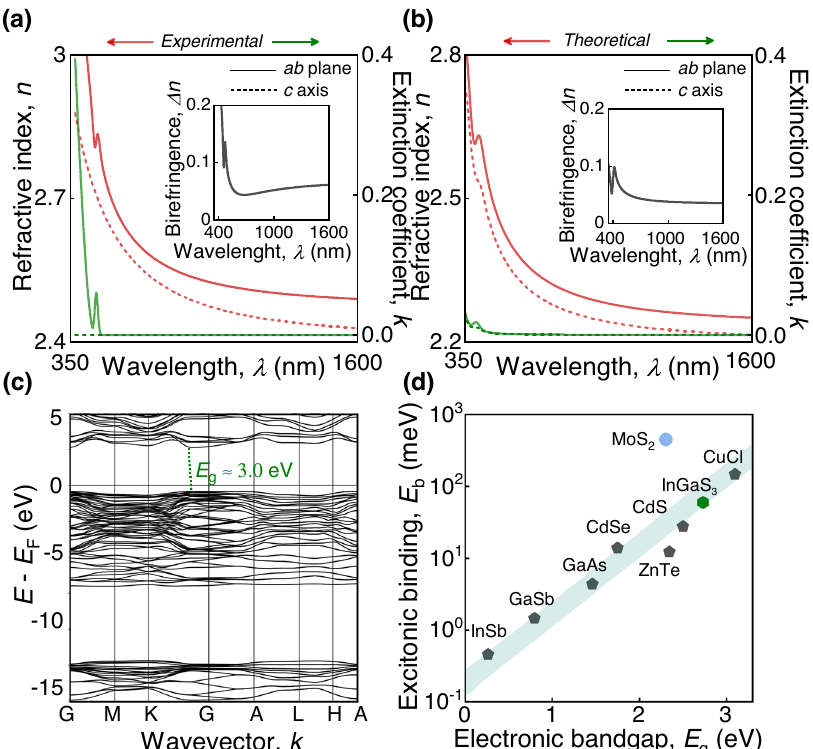
Fig. 3 Optical response of non-van der Waals InGaS 3 . a Experimental and b fi rst-principle refractive indices and extinction coef fi cients for ab -plane (straight line) and c -axis (dashed line) of commensurate values and trends validating the hexagonal structure of InGaS 3 (see Fig. 1(a (inset) and d)). Insets: material ’ s birefringence. c Electronic bandstructure from the fi rst-principle calculations. Fermi energy ( E F ) is shifted to zero for clarity. Electronic bandgap is of E g = 3 eV. d Excitonic binding energy versus electronic bandgap in traditional semiconductor materials. For a comparison, we also included the corresponding data for MoS 2 monolayer 55